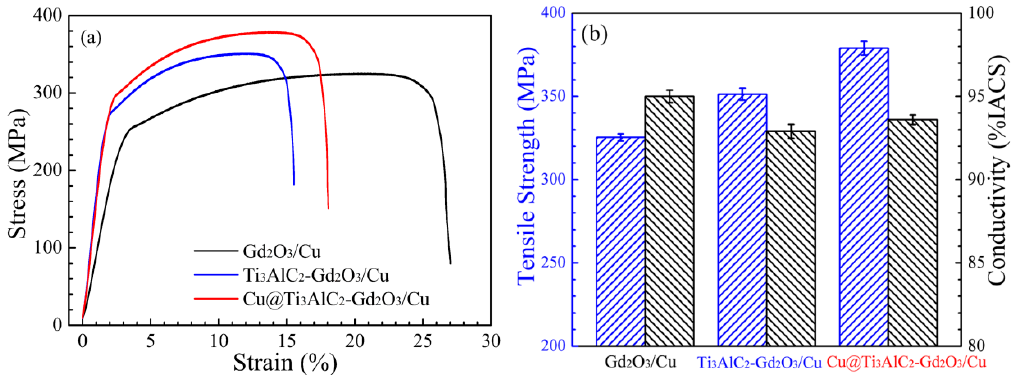
Figure 9. The stress–strain curve, tensile strength, and electrical conductivity of the composites: ( a ) the stress–strain curve and ( b ) the tensile strength and electrical conductivity.